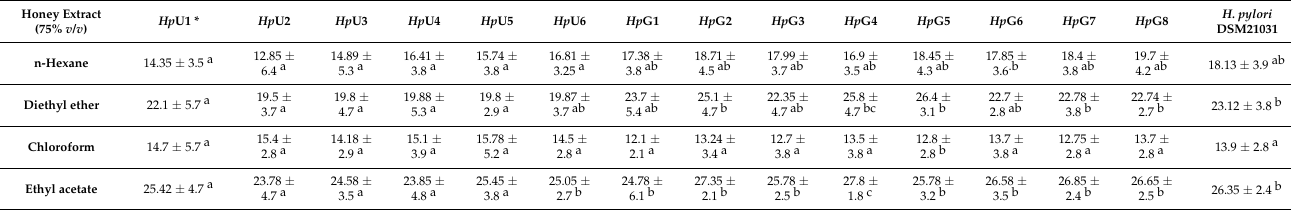
Table 3. Diameter of the inhibition zones (mm, mean±StDev) produced from various solvent extracts (75% v / v ) against 14 H. pylori strains isolated from ulcers ( n = 6) or gastritis ( n = 8) and a reference strain H. pylori DSM21031. Honey Extract (75% v / v )